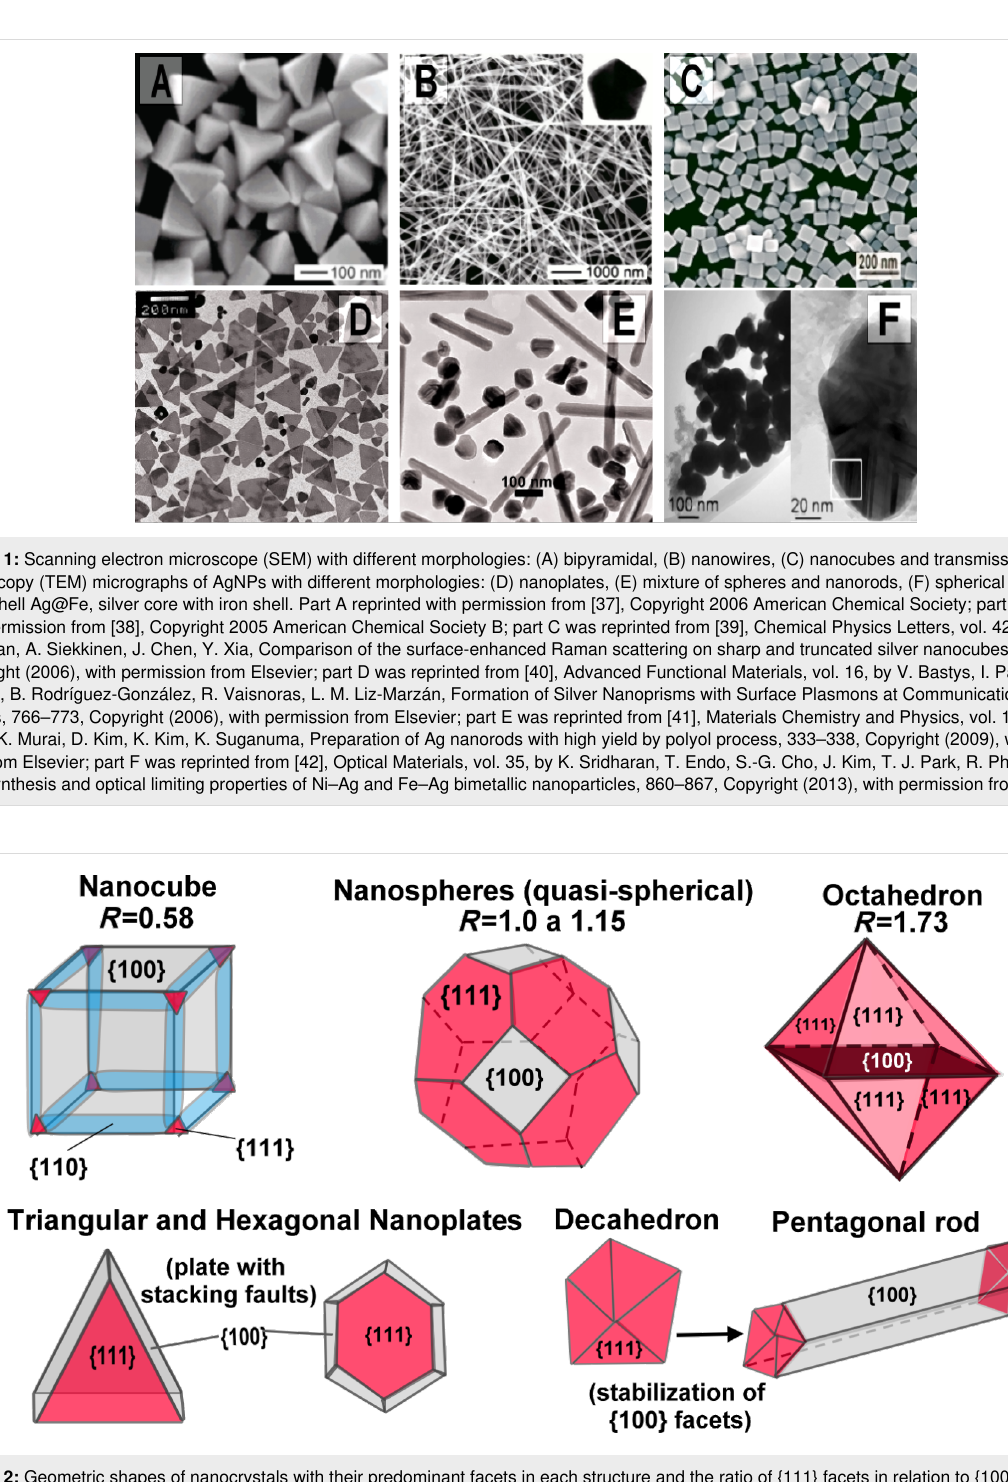
gy and concluded that the nanoplates had a greater biocidal ac- tivity due to the {111} facets when compared with nanospheres [29,45]. Acharya et al. evaluated the efficiency of spherical and rod-shaped AgNPs regarding their antibacterial activity against